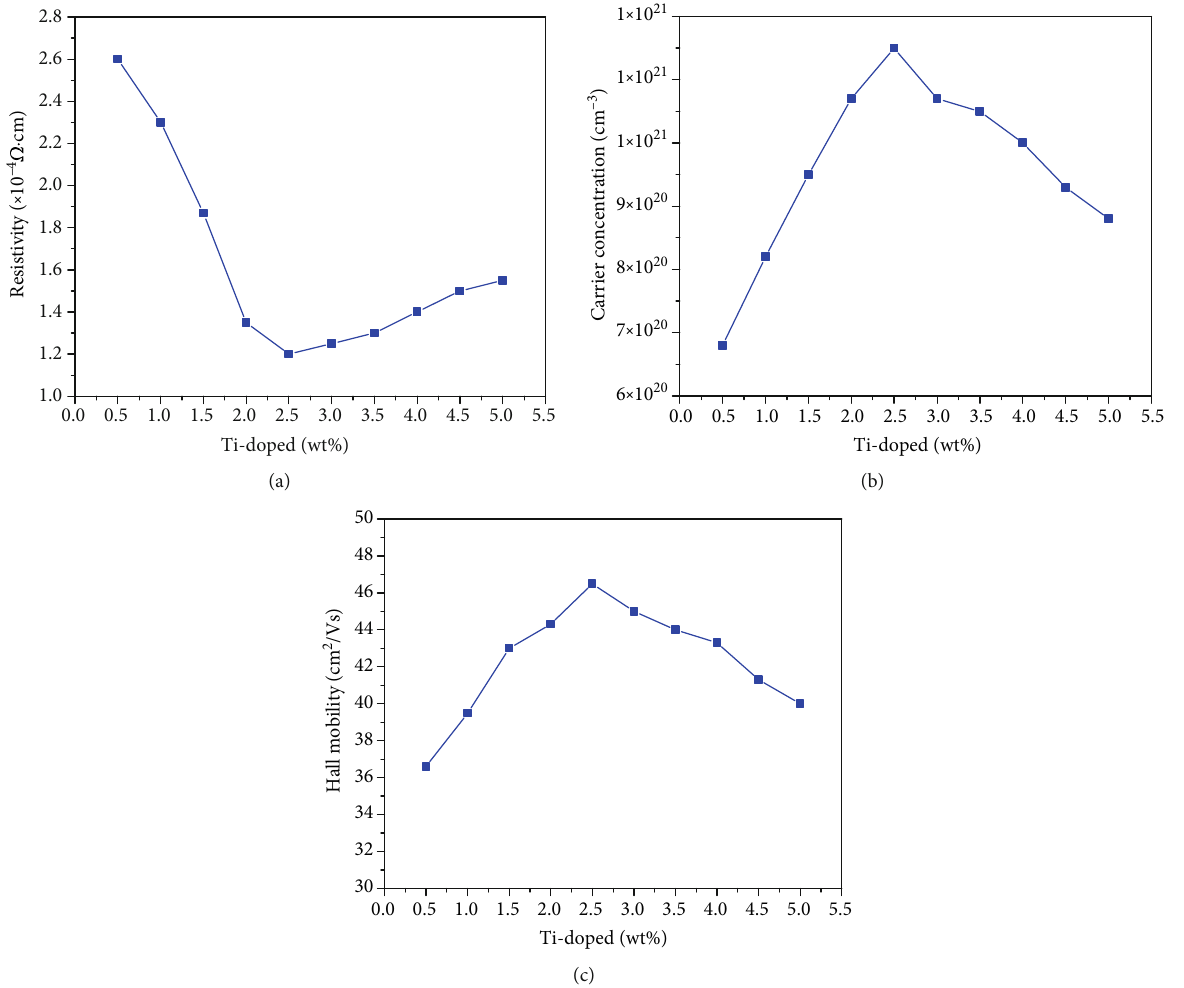
Figure 5: Overall variation in the electrical properties of the deposited fi lms of di ff erent Ti doping concentrations: (a) resistivity; (b) carrier concentration; (c) Hall mobility. Table 2: Comparison the electrical properties of the ITiO obtained from study to those of the fi lms deposited by other processes. Deposited methods of ITiO fi lms Without oxygen atmosphere 300 — RF magnetron sputtering (in fl uence of RF power conditions) Pulsed DC magnetron sputtering 450 Oxygen plasma treatment (PET substrate) 130 RF magnetron sputtering (in fl uence of Ti doping